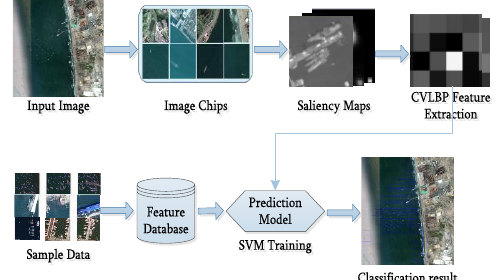
Figure 2. The flowchart of the proposed